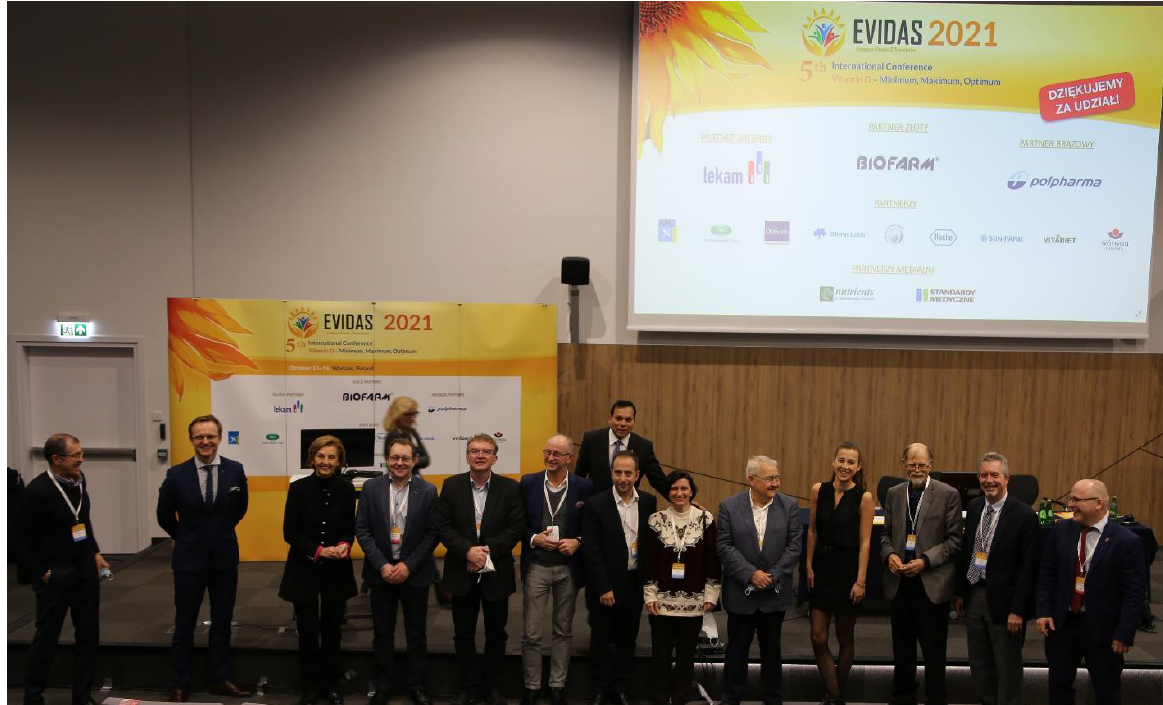
Figure 1. Dr William B Grant (3 rd from the right) with a group of participants attending the European Vitamin D Association (EVIDAS) congress in Warsaw in